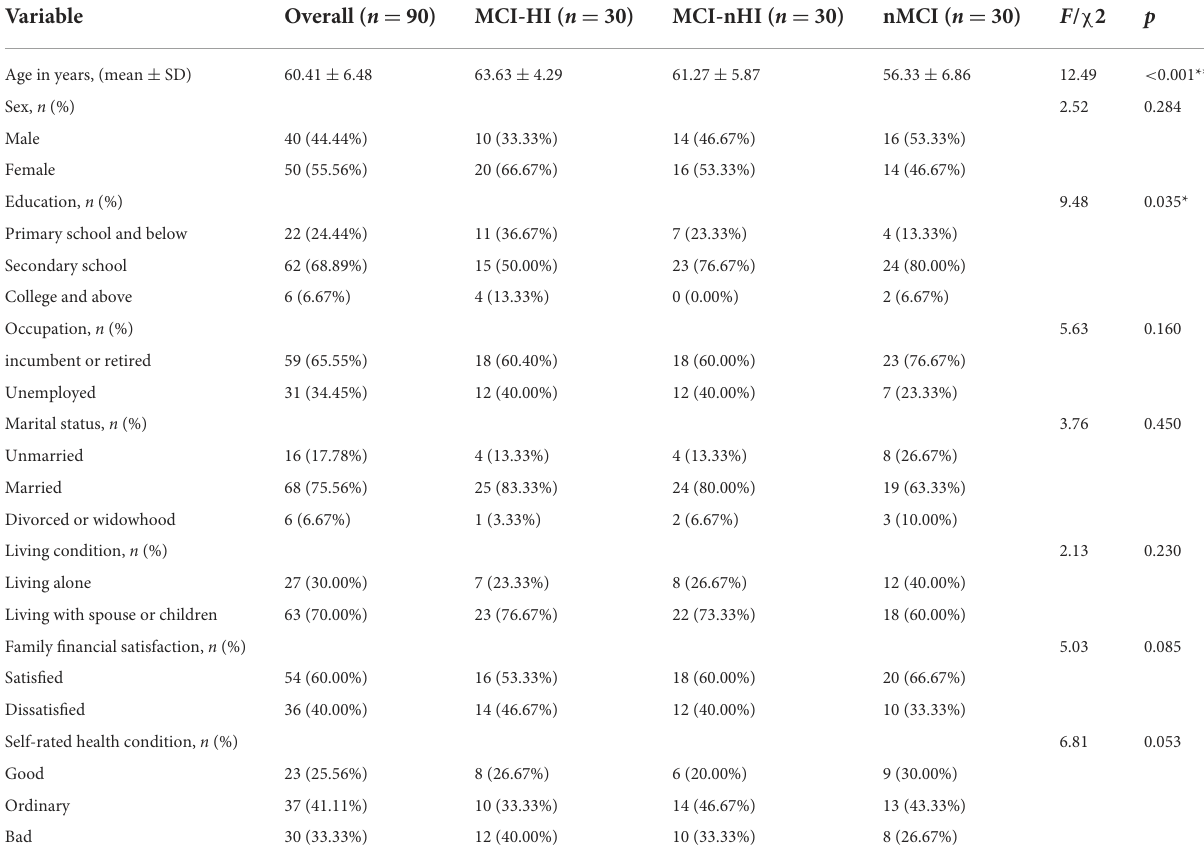
TABLE 1 Demographic characteristics of participants in each group.